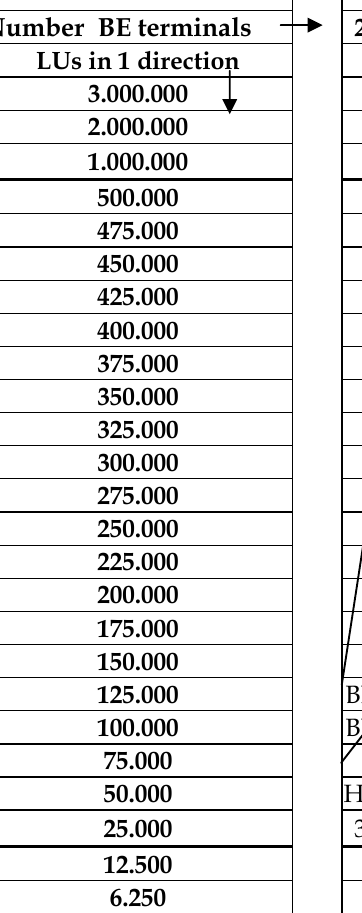
Figure 4. Bundling market diagram rail (700m trains, trainloading degrees ≥ 70%, *) 2 departures / work day 1 departure / work